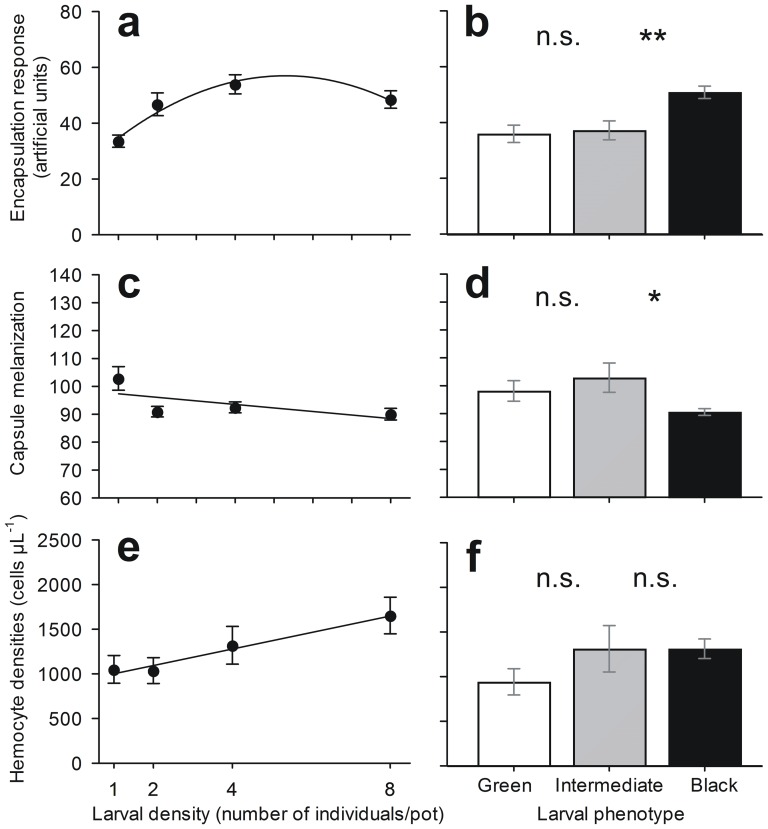
Immune response of Anticarsia gemmatalis larvae according to rearing density and resultant phenotype.Larvae were reared at four densities, 1, 2, 4 or 8 per cup, and expressed the phenotypes green, intermediate or black as a result (see Fig. 2); data are shown as responses to these two variables. To assess encapsulation responses and capsule melanization, a piece of sterile nylon filament was inserted through the first thoracic segment of 30 larvae/density, and after 24 h, the nylon filaments were mounted on slides where the two immune defense were assessed with aid of software. a) Encapsulation increases with density; shown is the curve of best model fit. The simplest model shows that encapsulation is lower in solitarious larvae than in those in the presence of conspecifics (means±SE). b) Less encapsulation occurred in green and intermediate than in black phenotypes. c) Capsule melanization decreases with density; shown is the curve of best model fit. The simplest model shows that capsule melanization is higher in solitarious larvae than in those in the presence of conspecifics (means±SE). d) More encapsulation occured in green and intermediate than in black phenotypes. To count the cell numbers, a hemolymph aliquot was extracted from each larva (30 larvae/density), placed in a Neubauer improved chamber, and counted under a microscope. e) Hemocyte densities increase with density; shown is the curve of best model fit. The simplest model shows that hemocyte densities is a result of the rearing density whereas there was difference between densities 8 and the remaining (means±SE). f) Hemocyte densities did not vary with the larval phenotype. Variables were amalgamated when the mean values were not significantly different (F-tests: *P<0.05, **P<0.01, n.s. = not significant; see table 1 for details).